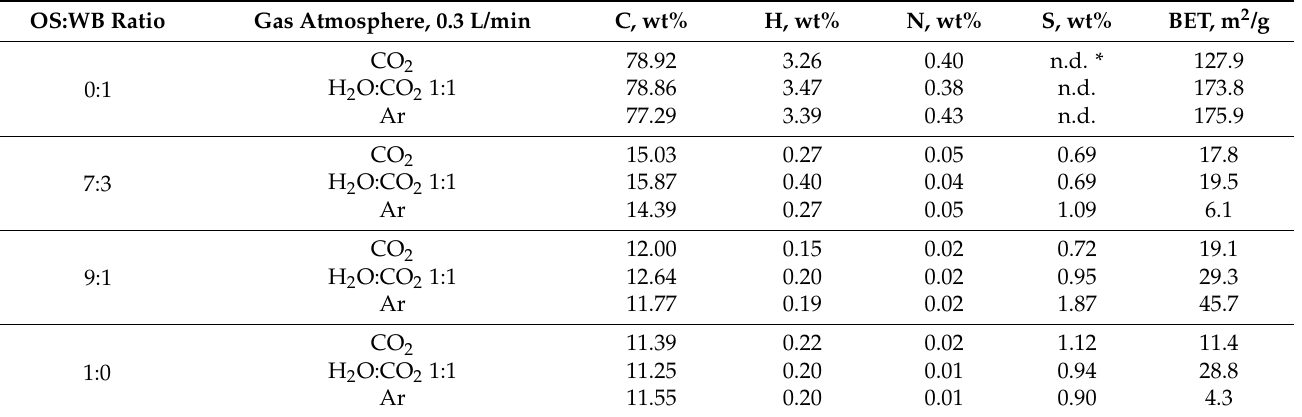
Table 3. Elemental composition of OS, WB, and OS:WB solid products, BET surface area of solid